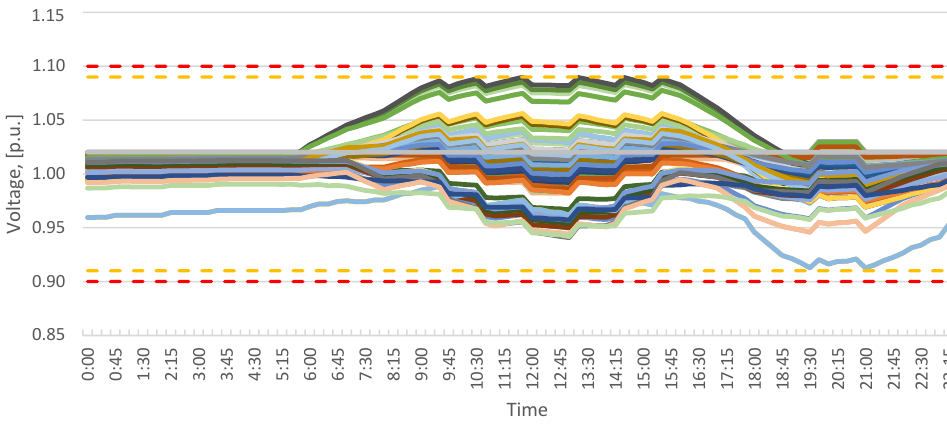
Figure 10. Baseline voltage profiles, after the application of the LVC controlling all